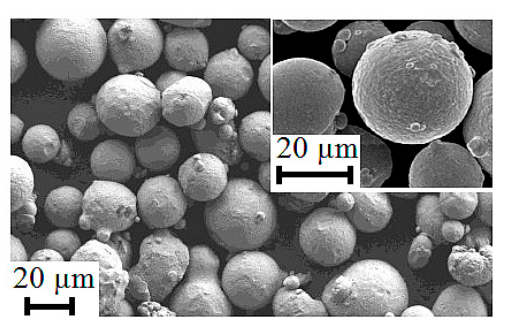
Table 1. Material chemical composition by percent of weight of Inconel 718.